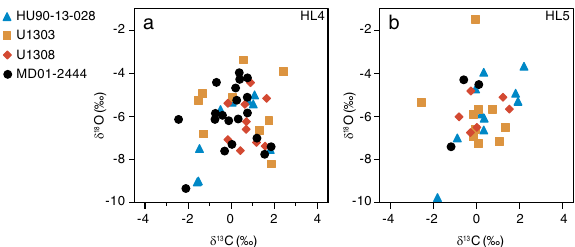
Fig. 3 Isotopic composition of carbonate grains from Heinrich layers HL4 and HL5. a δ 18 O and δ 13 C measured on single detrital carbonate grains from depths 10.06 m (HL4) in core MD01-2444 (circles) (this study) compared to the δ 18 O and δ 13 C composition of detrital carbonate grains 36 from HL4 in cores HU90-13-028 (triangles), U1303 (squares) and U1308 (diamonds) in the North Atlantic. b δ 18 O and δ 13 C measured on single detrital carbonate grains from depth 11.98 m (HL5) in core MD01-2444 (circles) (this study) compared to the δ 18 O and δ 13 C composition of detrital carbonate grains 36 from HL5 in cores HU90-13-028 (triangles), U1303 (squares) and U1308 (diamonds) in the